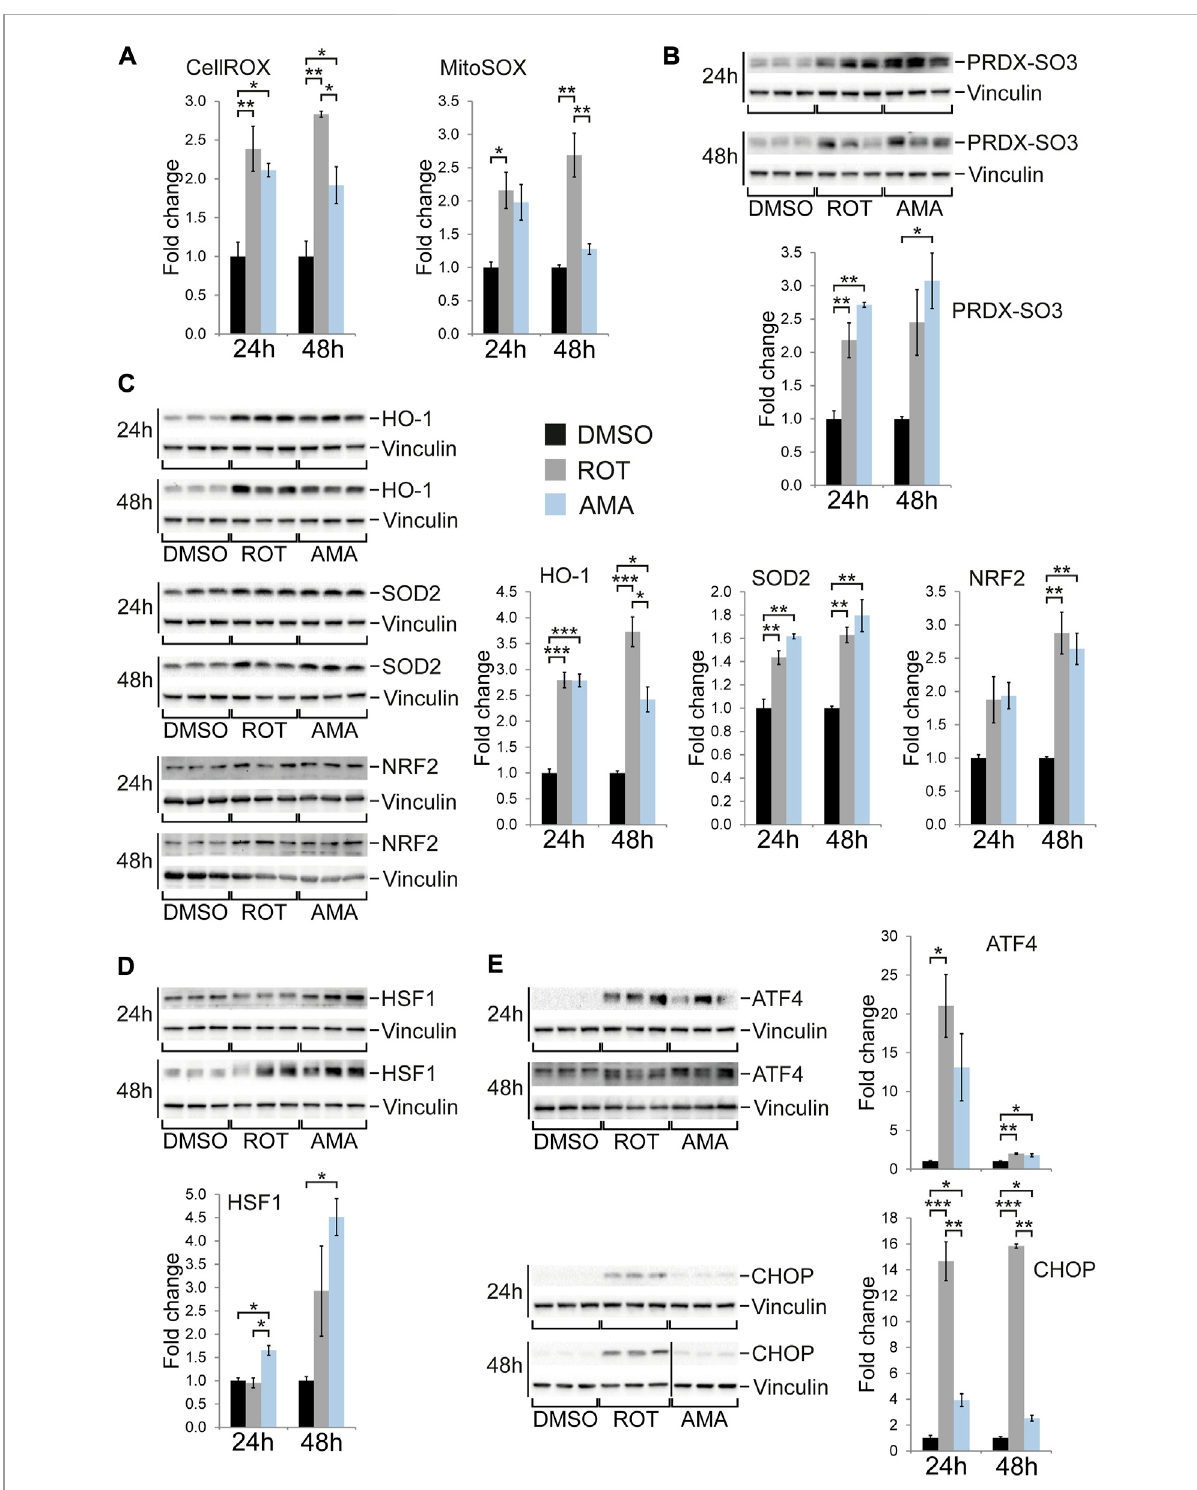
OxidativestressandcellularstressresponseinH9c2cellstreatedwithrotenoneandantimycinA. (A) Generationofreactiveoxygenspecieswas evaluated using the fl uorescence probes CellROX and MitoSOX in H9c2 cells treated with ROT (10 µM) and AMA (50 µM) for 24 and 48 h. Fluorescence intensity was measured in a plate reader and related to DMSO treated controls. (B) Western blots for hyperoxidized peroxiredoxin (PRDX-SO3) in H9c2 cells treated with ROT and AMA for 24 and 48 h. (C) Western blots of enzymes involved in antioxidative defense [heme